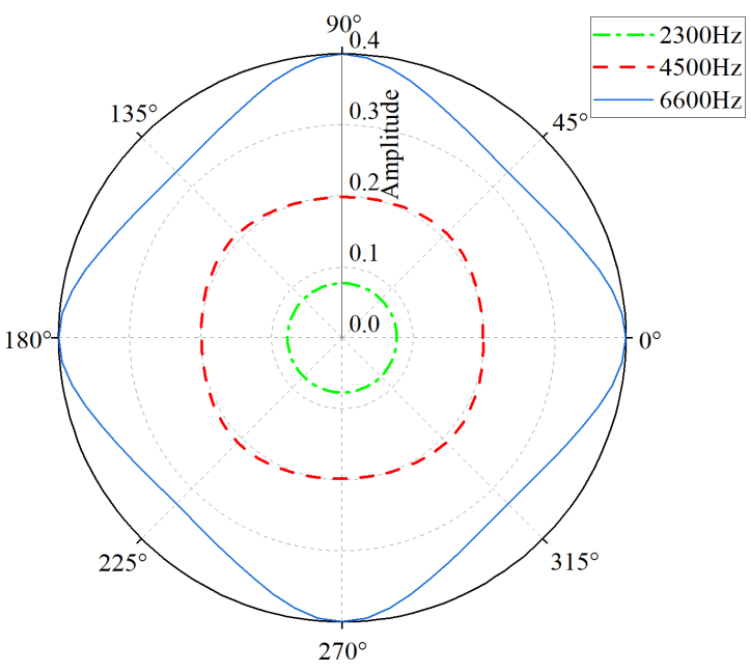
Figure 10. ( a ) Band structure in the MΓ direction; ( b ) Attenuation constant in the MΓ direction.